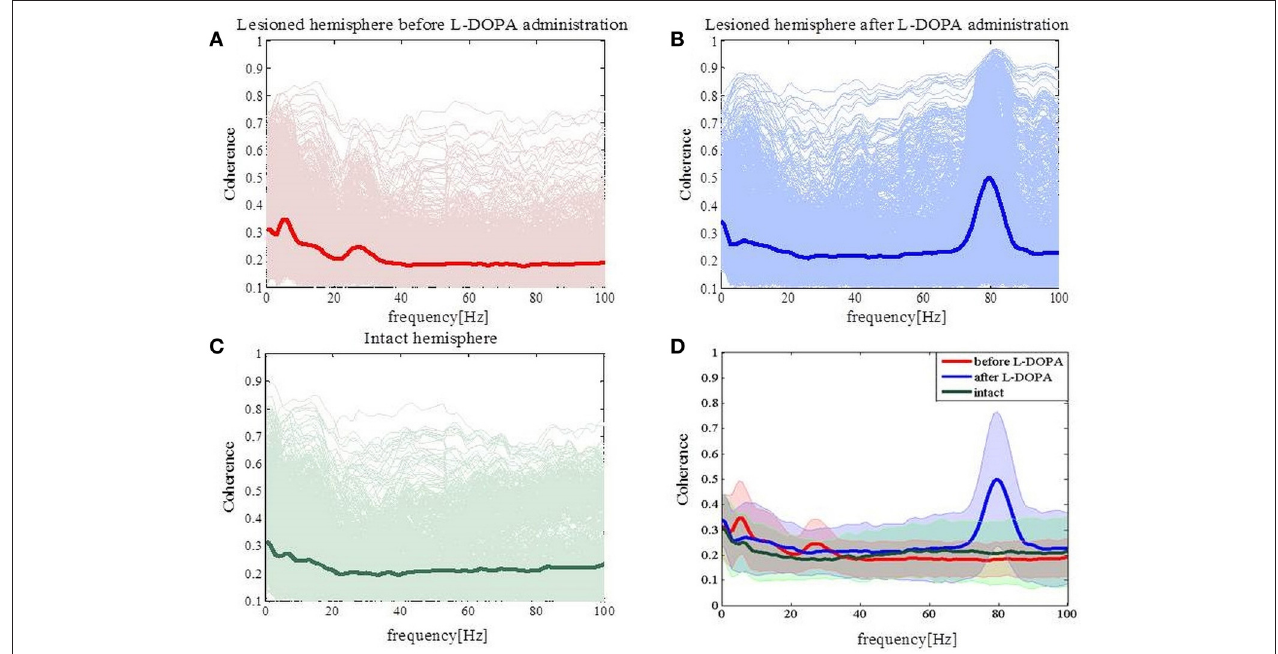
FIGURE 3 | Coherence spectra analysis. (A) Coherence has increased for low frequencies ( < 10Hz) and for high beta frequencies in the case of the lesioned right hemisphere. (B) Coherence has peak values at high gamma frequencies (around 80Hz). (C) In the case of the intact left hemisphere, we did not see any prominent increase in the coherence. (D) Average values of coherences for the intact and lesioned hemispheres. Shaded areas represent variability in the data as measured by the standard